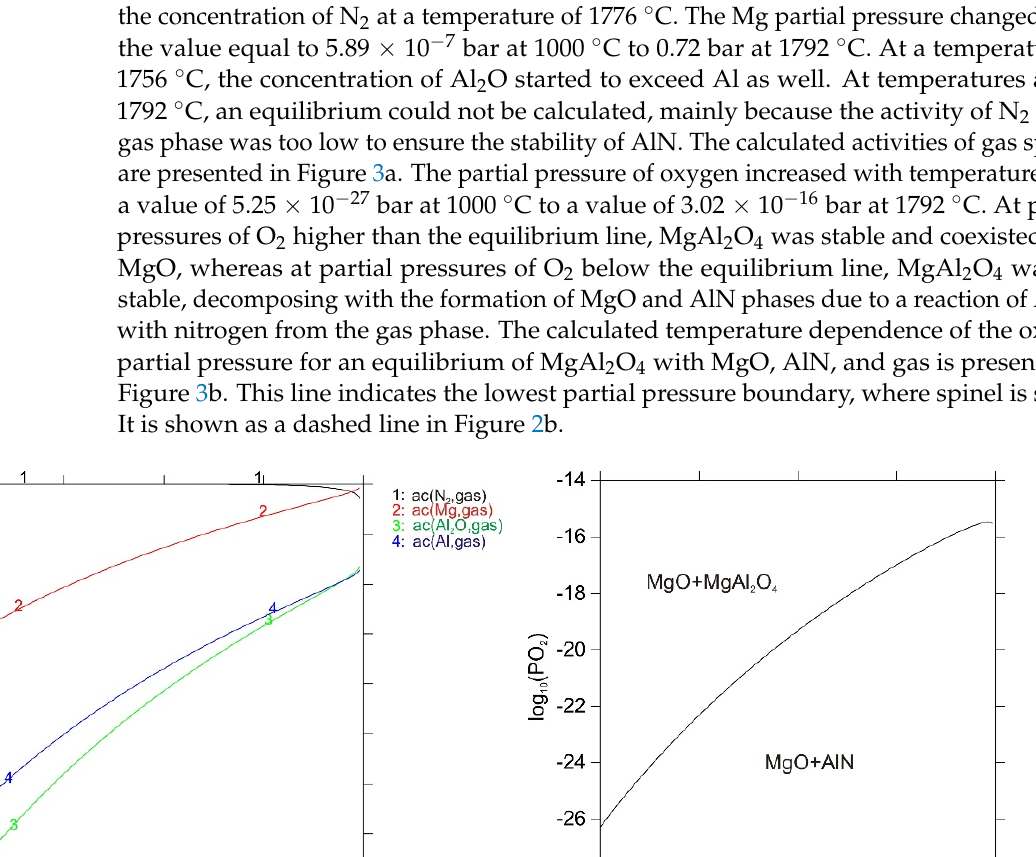
Figure 3. Equilibrium of MgAl 2 O 4 with MgO and AlN in the presence of gas as a function of temperature: ( a ) activities of gas species and ( b ) partial pressure of oxygen (in bar).